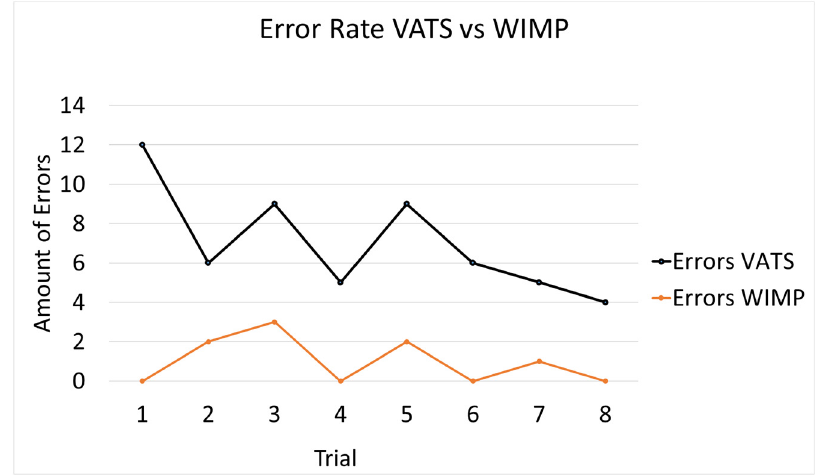
Figure 9. Amount of errors for VATS and WIMP. VATS error = wrong selected grip type. Error WIMP = not completed task.